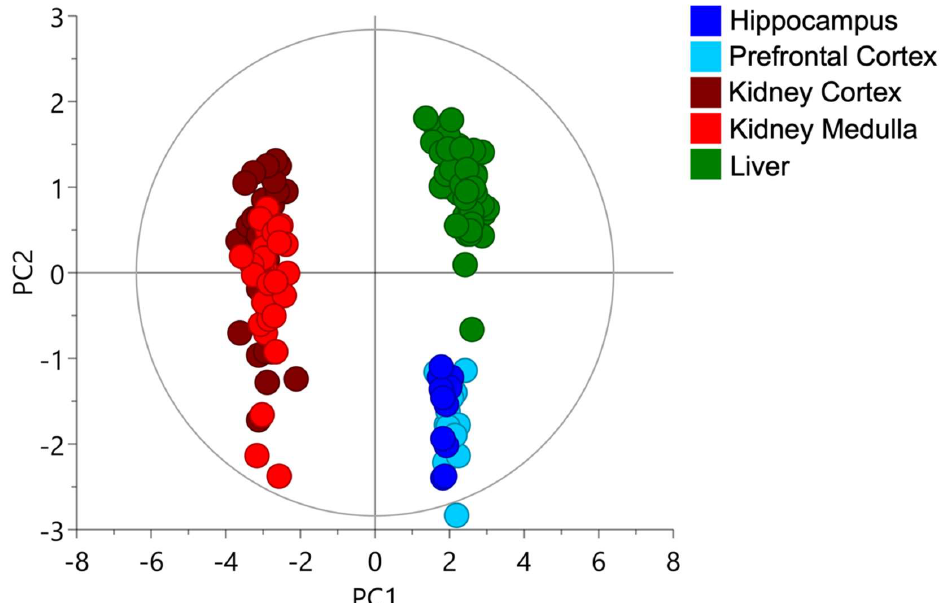
Figure 2. Organ dependence of the cysteine-related thiolome . Principal Component Analysis (Score plot) with all studied organs; first two components covered 77 and 15% of the variance of the data, respectively. A total of 17 samples of brain tissue, 33 of kidney tissue and 53 of liver tissue were analyzed. PC: Principal Component.